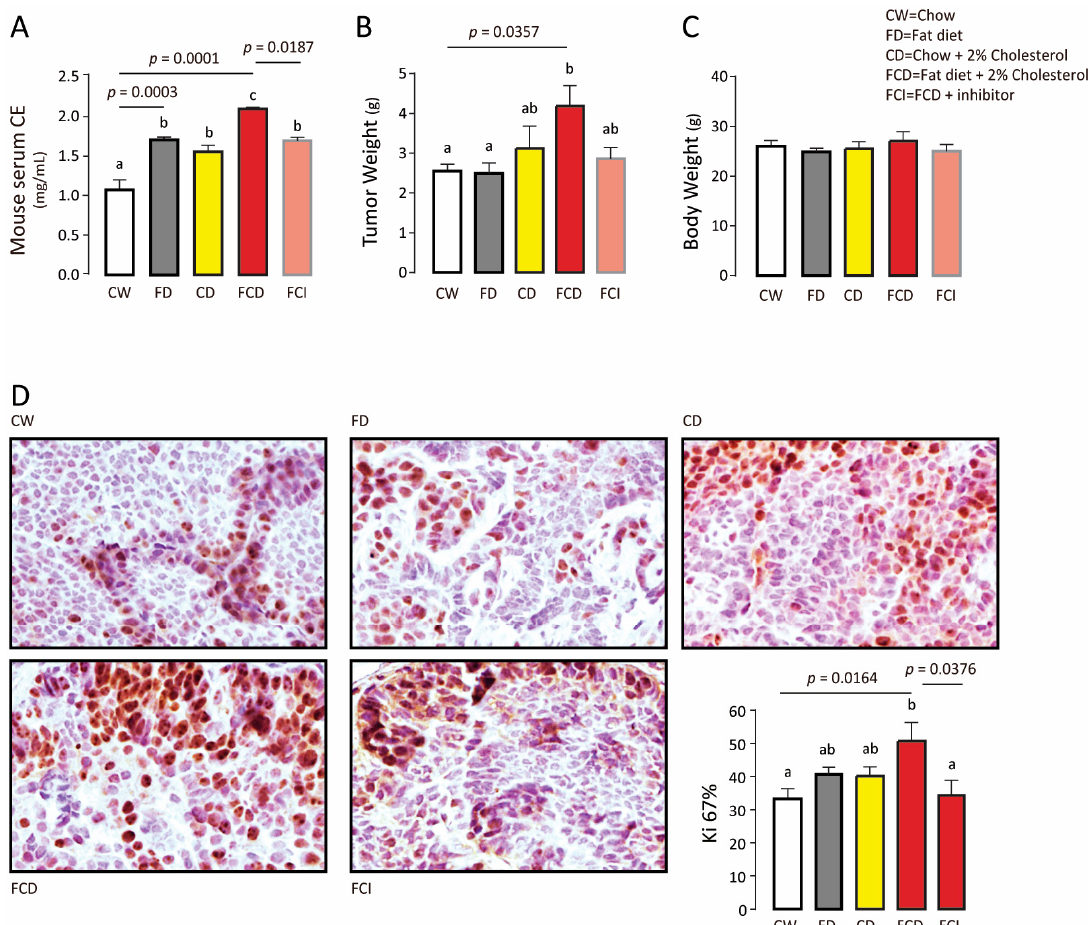
Figure 3. Endogenous cholesteryl ester promotes tumor proliferation. ( A ) Serum CE of each group. ( B ) Tumor weight of each group. ( C ) Body weight of each group. ( D ) Immunohistochemical staining of Ki-67 in mammary gland (tumor). For experiments where necessary, ANOVA (Tukey’s test) was performed and p < 0.05 was considered as significant. Values (means ± S.E.M.) with different letters indicate statistical significance.